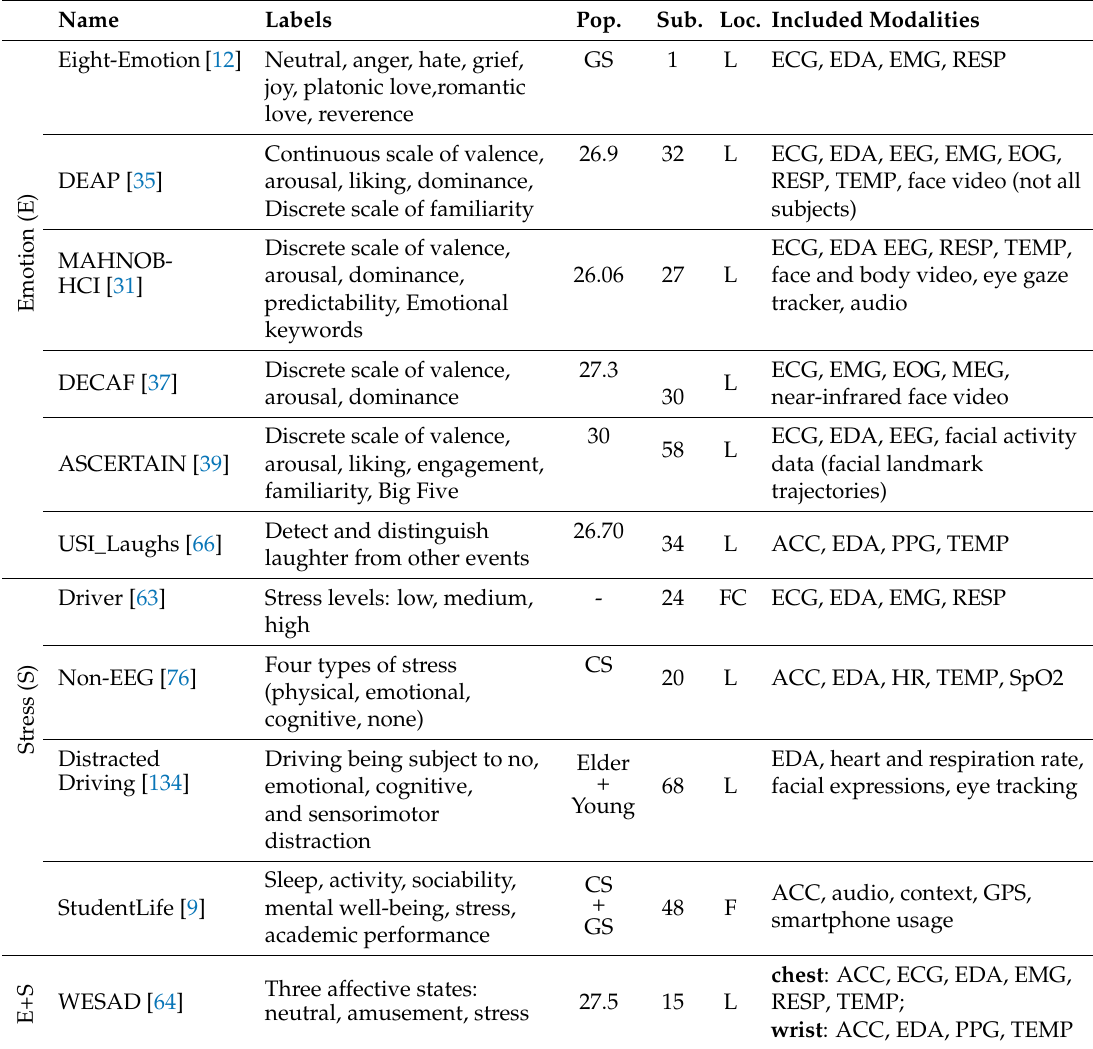
Table 7. Publicly available datasets relevant for wearable affect and stress recognition. Abbreviations: Number of subjects (Sub), Location (Loc), Lab (L), Field (F), Field with constraint (FC), Population (Pop) reported as mean age or as category, College Student (CS), Graduate Student (GS), 3-axes acceleration (ACC), electrocardiogram (ECG), electrodermal activity (EDA), electroencephalogram (EEG), electromyogram (EMG), electrooculography (EOG), magnetoencephalogram (MEG), respiration (RESP), arterial oxygen level (SpO2), skin-temperature